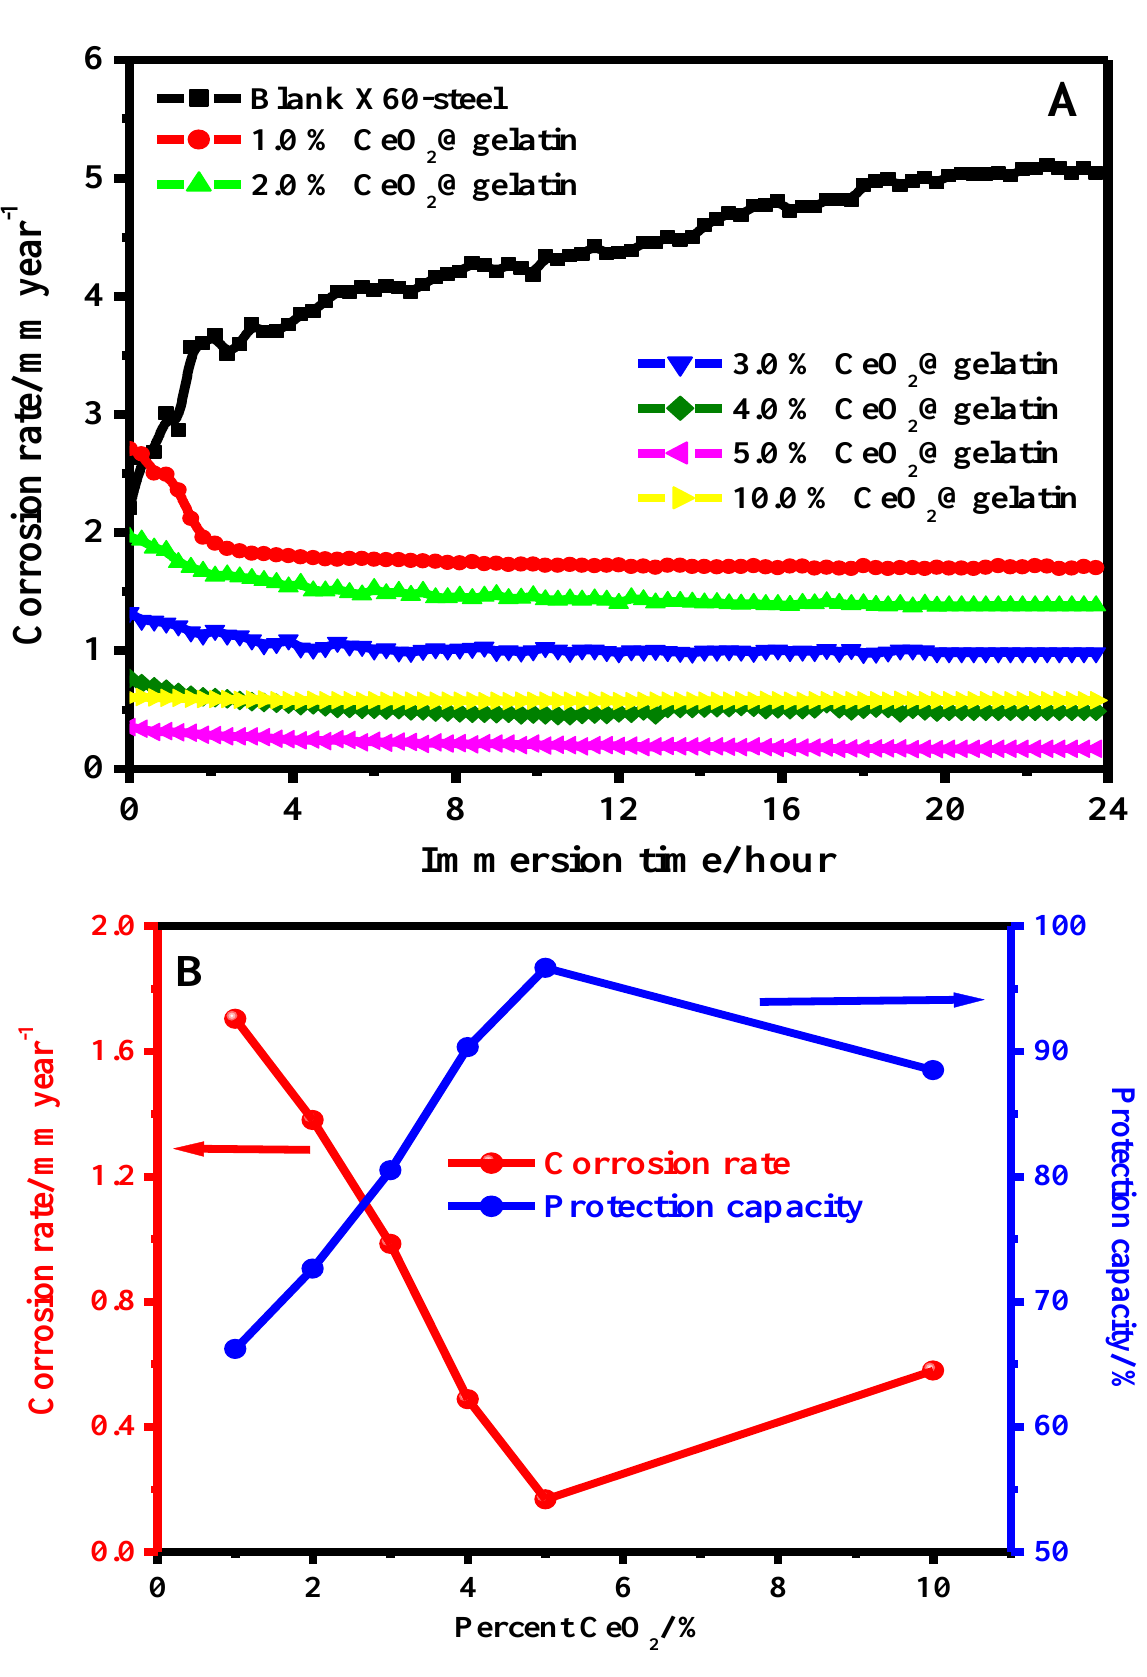
Figure 9. Effect of exposure time on the corrosion rate for blank X60-steel and coated samples with different percent of % CeO 2 @gelatin in 15% HCl solution at 50 °C ( A , B ) the effect of CeO 2 percent on the corrosion rate and protection capacity after 24 h of exposure.